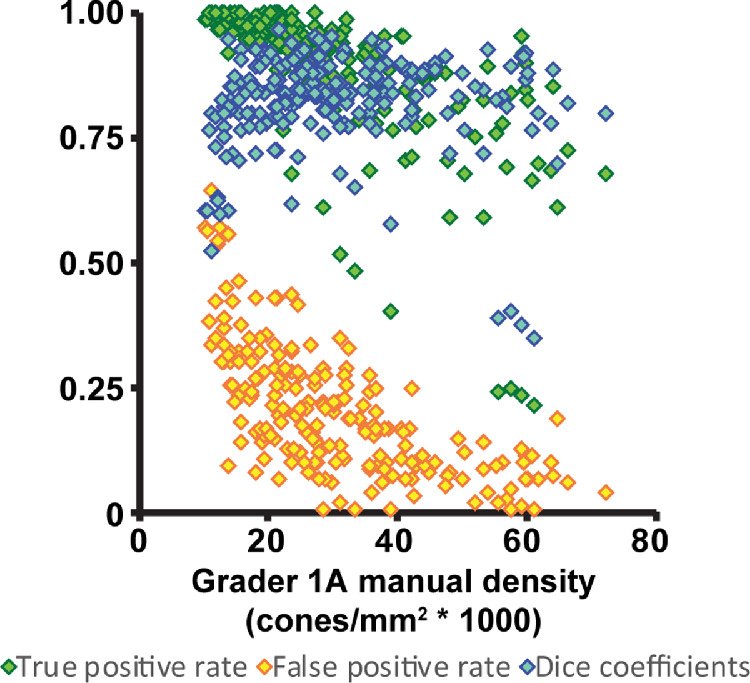
True positive and false positive rates and Dice coefficient for the CHM-1A-CNN plotted versus the calculated cone densities from grader 1A. The false positive rate is higher for ROIs that have a lower manual cone density. The true positive rate is lower for ROIs that have a higher manual cone density. The Dice coefficient depends on both the true positive and false positive rates, resulting in lower Dice coefficients for high and low manual density ROIs and higher Dice coefficients for ROIs with mid-range manual cone densities. Green diamonds = true positive rates; yellow diamonds = false positive rates; and blue diamonds = Dice coefficients.